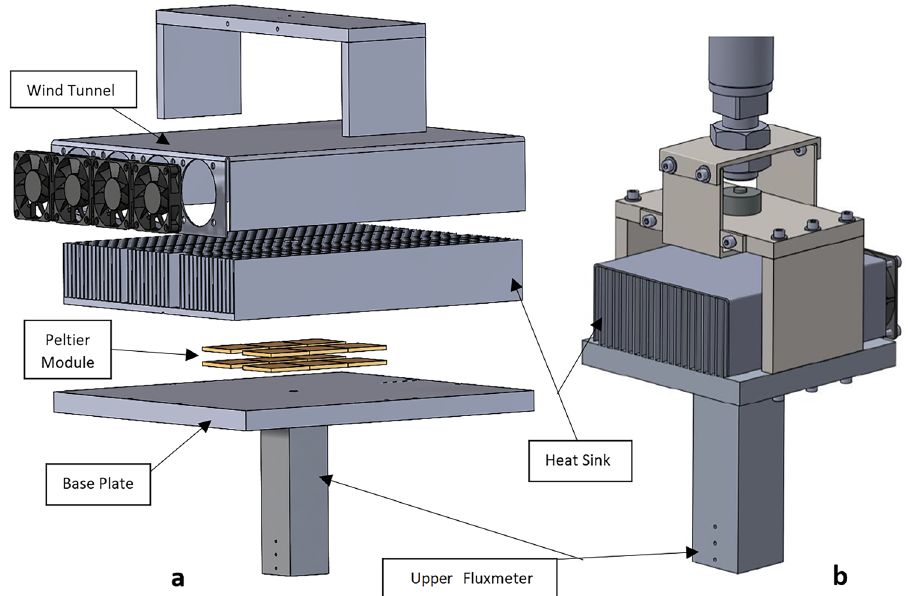
Fig. 3 Comparison of the original bench and the modi- fication. From left to right a modification, b